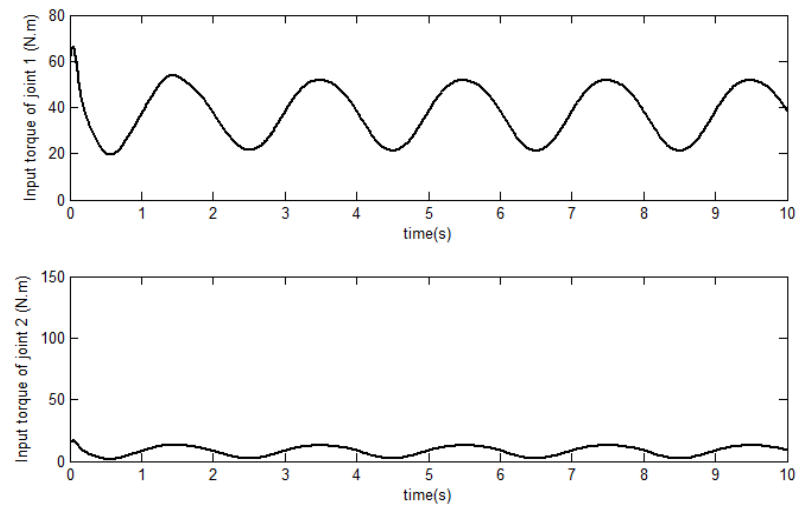
Figure 9. The control inputs of ARA joints.